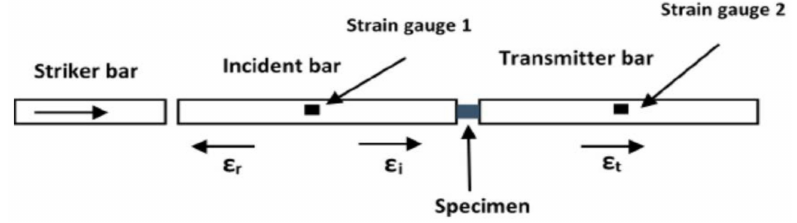
Figure 1. Schematic diagram illustrating the compression SHPB experimental